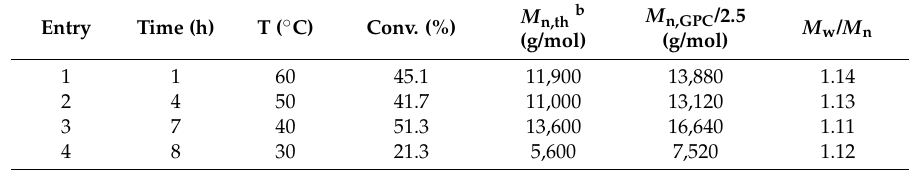
Table 3. Effect of polymerization temperature on ICAR ATRP of AN under high pressure a